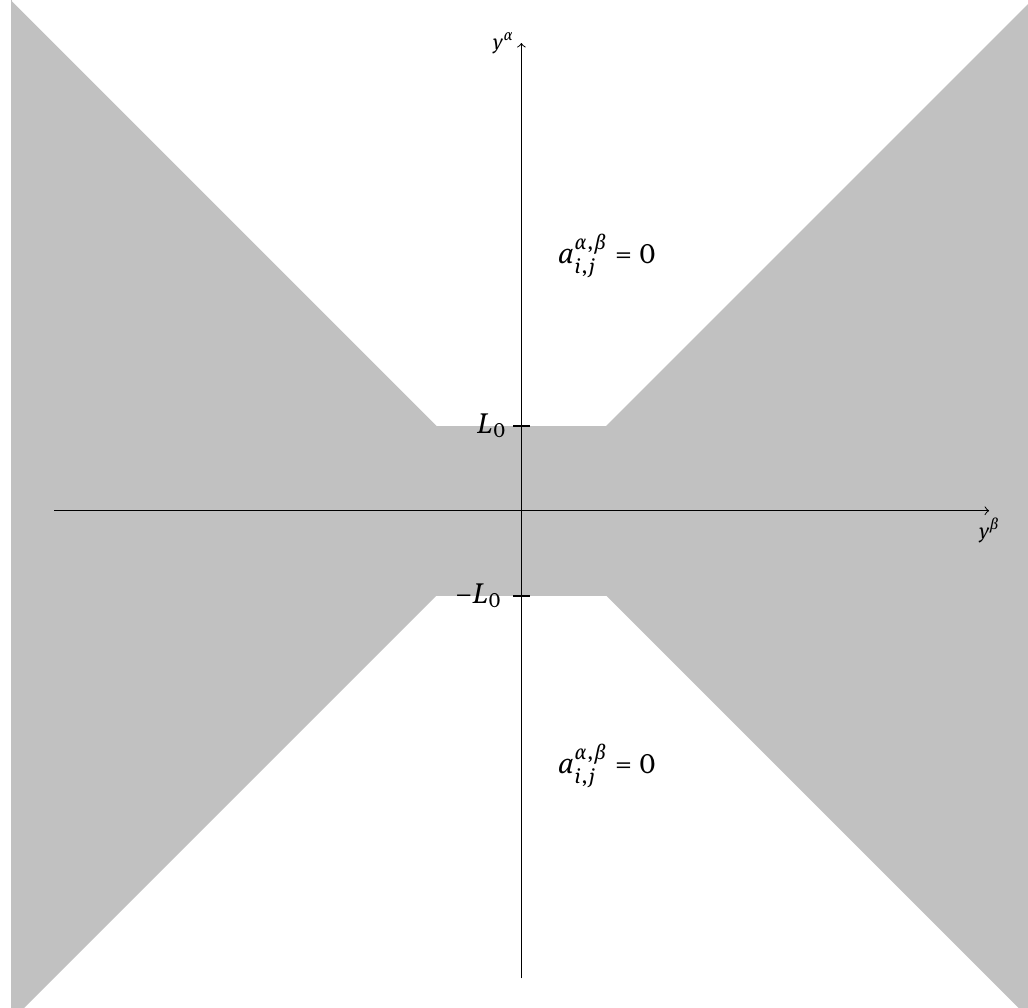
vanish on the white part of the picture; they might be non zero only on i , j